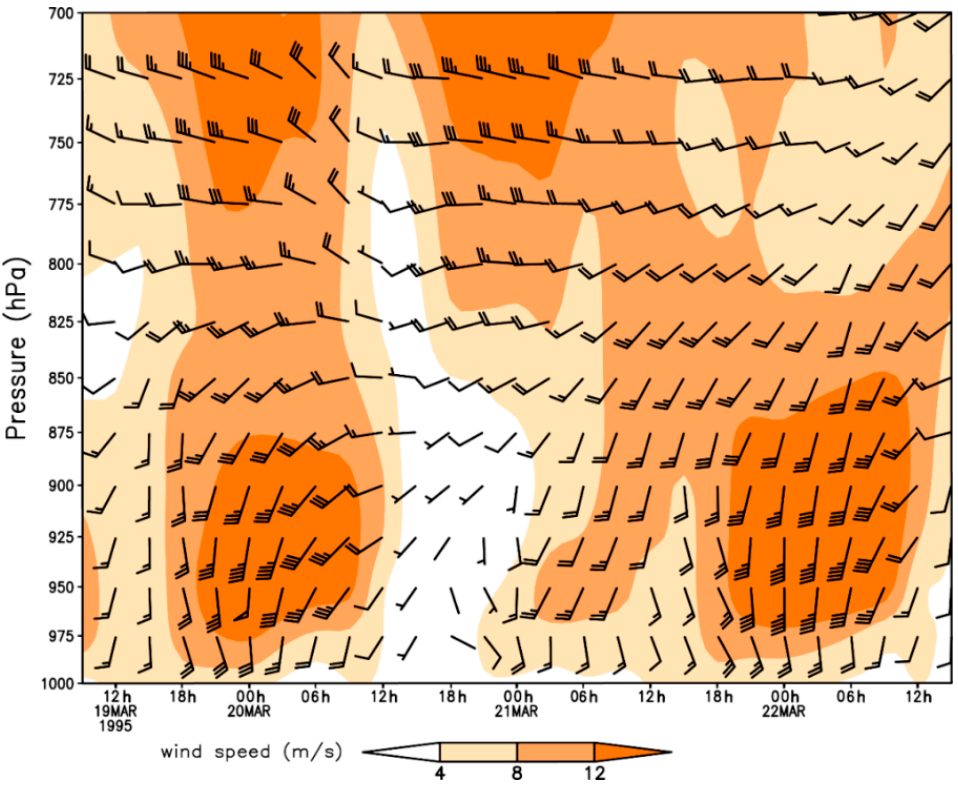
Figure 3. Vertical profile wind field with pressure-altitude and time for the period of 19–21 March 1995 at Karnes City, Texas, USA.